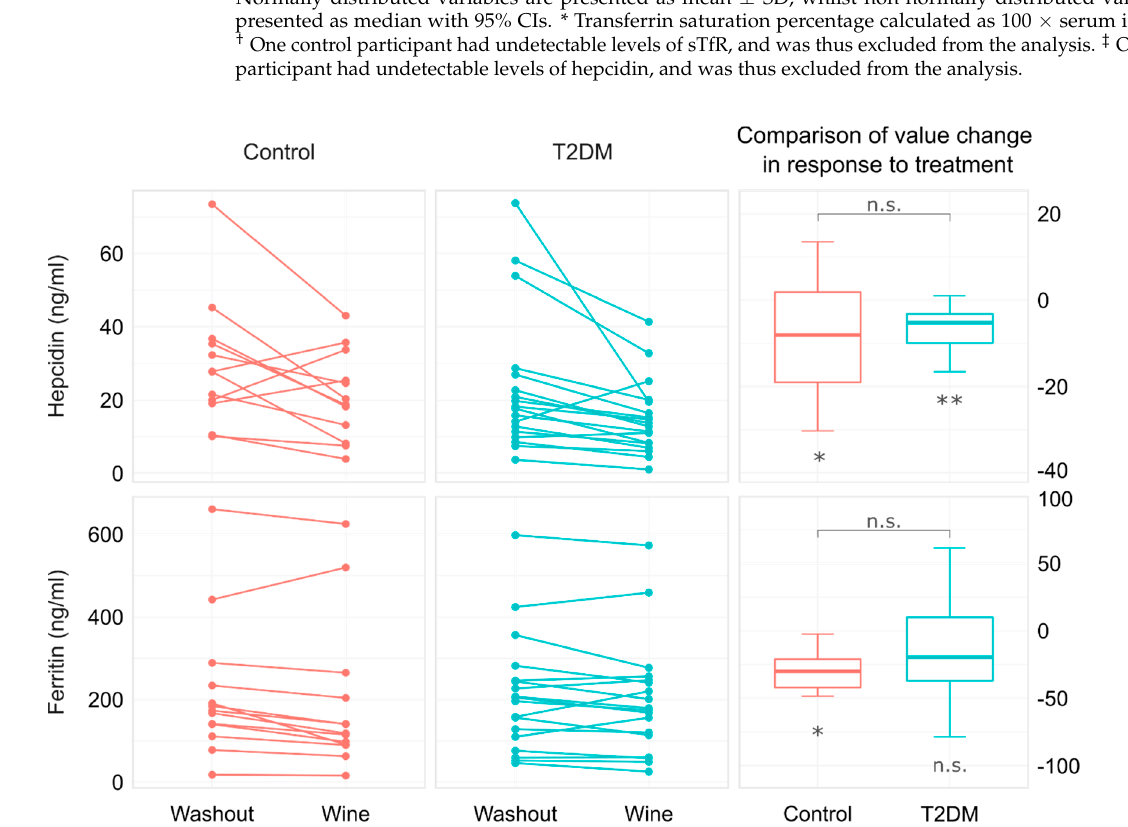
Table 2. Laboratory indicators of the iron status of participants with type 2 diabetes mellitus and control subjects and at pre- and post-intervention.